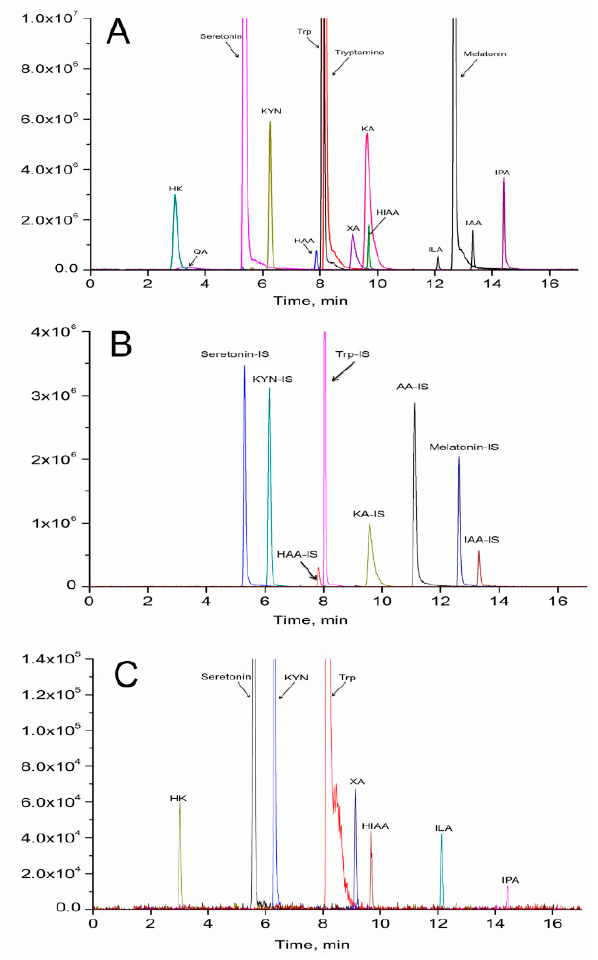
Figure 7. Representative UPLC-MS/MS chromatograms of tryptophan metabolites. ( A ) unlabeled tryptophan metabolites; ( B ) isotope labeled internal standards; ( C ) serum sample.